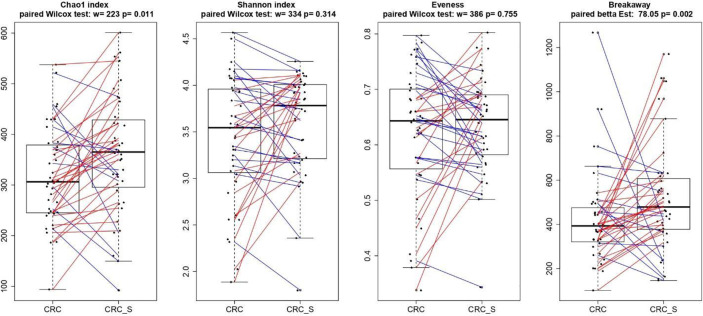
Boxplots showcasing alpha diversity indices (Chao1 index, Shannon index, Evenness, and Breakaway) in CRC and CRC-S samples. Statistical differences were evaluated using paired Wilcoxon signed-rank test for Chao, Shannon, and Evenness indices and using the paired betta analysis implemented in the Breakaway R package. P-values less than 0.05 were considered statistically significant.